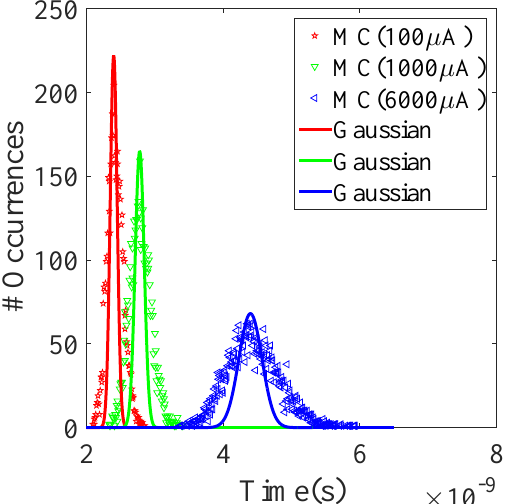
Figure 9. Process variation analysis using 5000 Monte Carlo simulations.